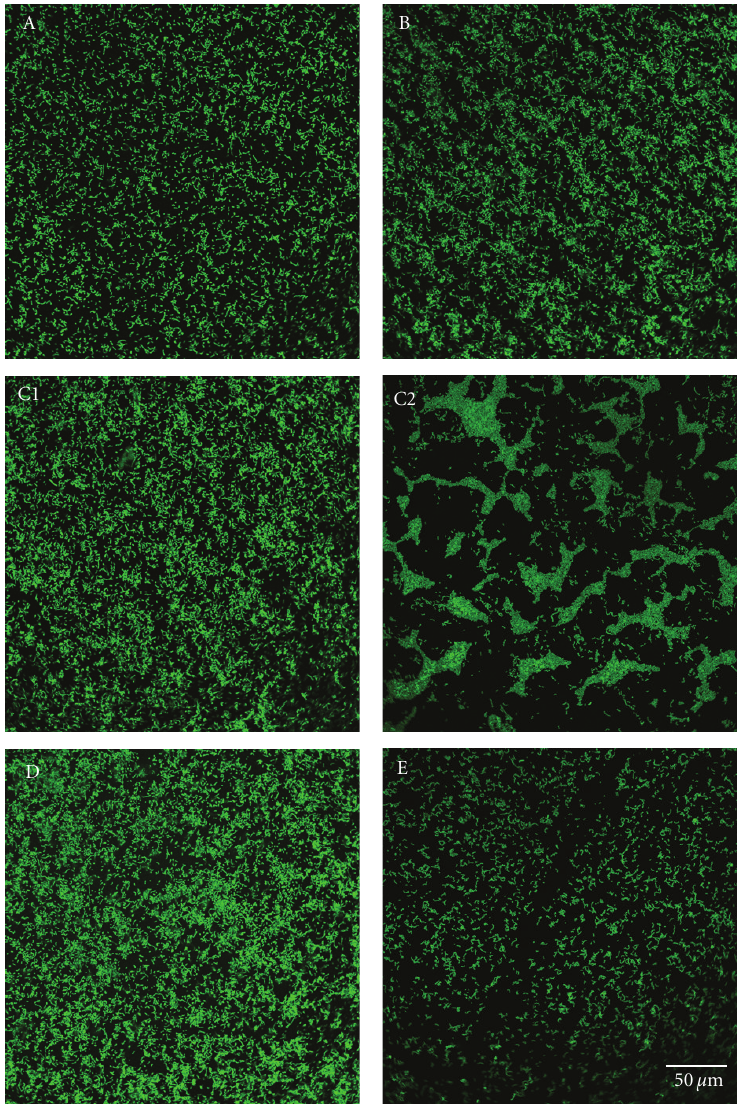
Figure 8: Streptococcus mutans cultured on glass coated with nonhexylated polymer (A), glass coated with hexylated polymer (B), glass coated with hexylated polymer and spin coated with amorphous silicon dioxide (C1 = middle; C2 = border), glass coated with hexylated polymer and spin coated with nanoporous silicon dioxide (D), and untreated glass (E).